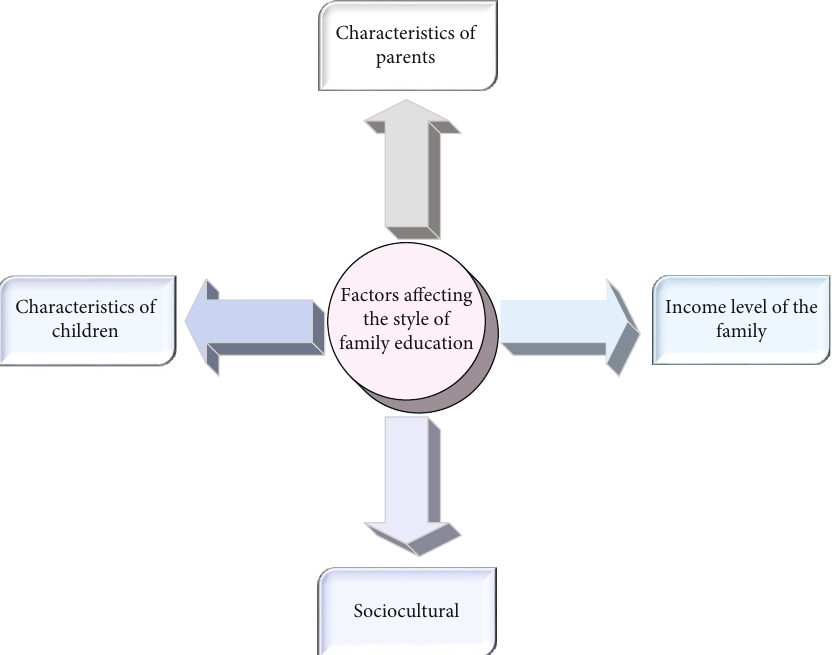
Figure 1: Factors a ff ecting family parenting